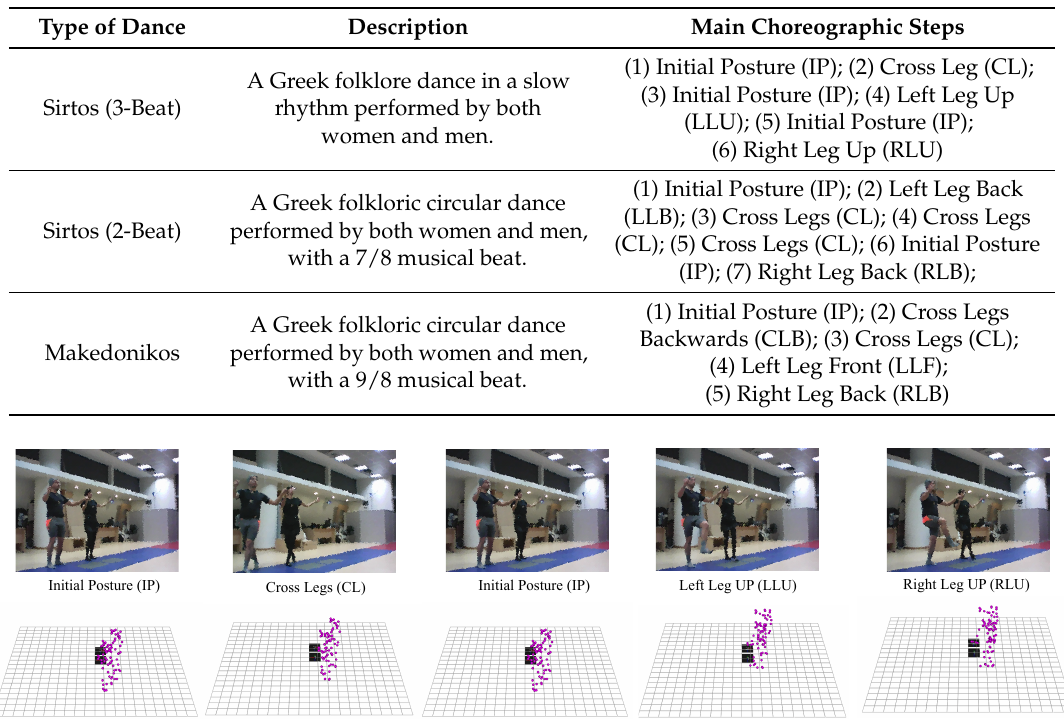
Table 1. A brief description of the recorded dances.